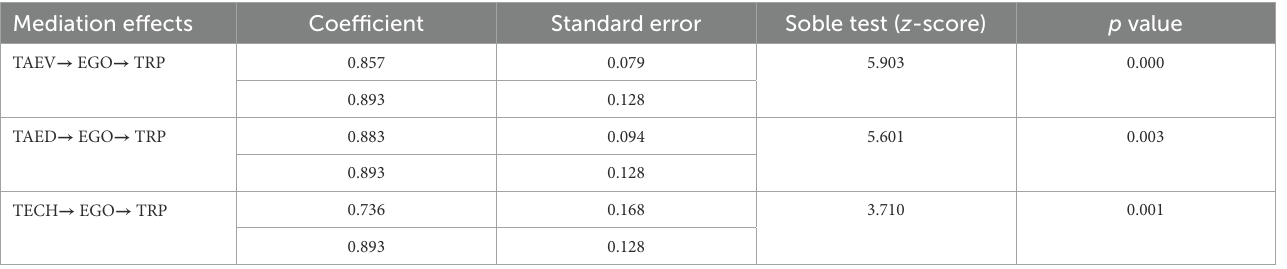
TABLE 4 The result of the mediation